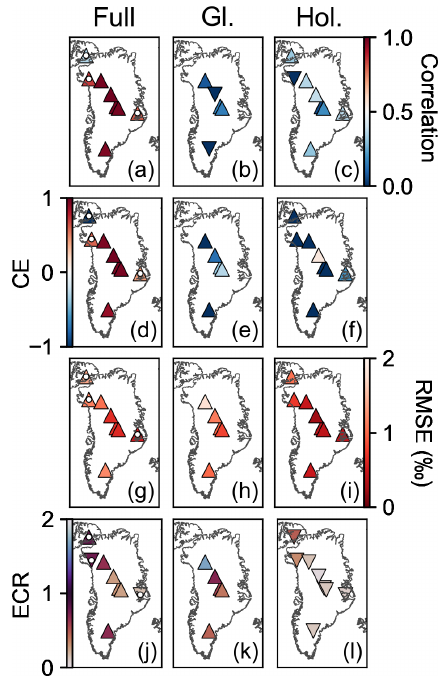
Figure 6. Skill metrics averaged over iterations and time for the temperature reanalysis. The first column (a, d, g, j) shows the skill metrics for the full overlap (Full) between the proxy record and reanalysis. A white dot indicates evaluation against proxy records that overlap only the Holocene (11.7–0ka). The middle col- umn (b, e, h, k) shows the skill metrics for a period in the glacial (Gl.) (20–15ka), while the right column (c, f, i, l) is for a period in the Holocene (Hol.) (8–3ka). The first row (a–c) reports the corre- lation coefficient, the second row (d–f) the coefficient of efficiency (CE), the third (g–i) the root mean square error (RMSE), and the fourth row (j–l) the ensemble calibration ratio (ECR). Triangle sym- bols pointing up indicate that the posterior ensemble evaluates bet- ter than the prior ensemble for that location and statistic. Triangle symbols pointing down indicate the opposite. We define better eval- uation as correlation coefficient closer to 1, CE closer to 1, RMSE closer to 0, and ECR closer to